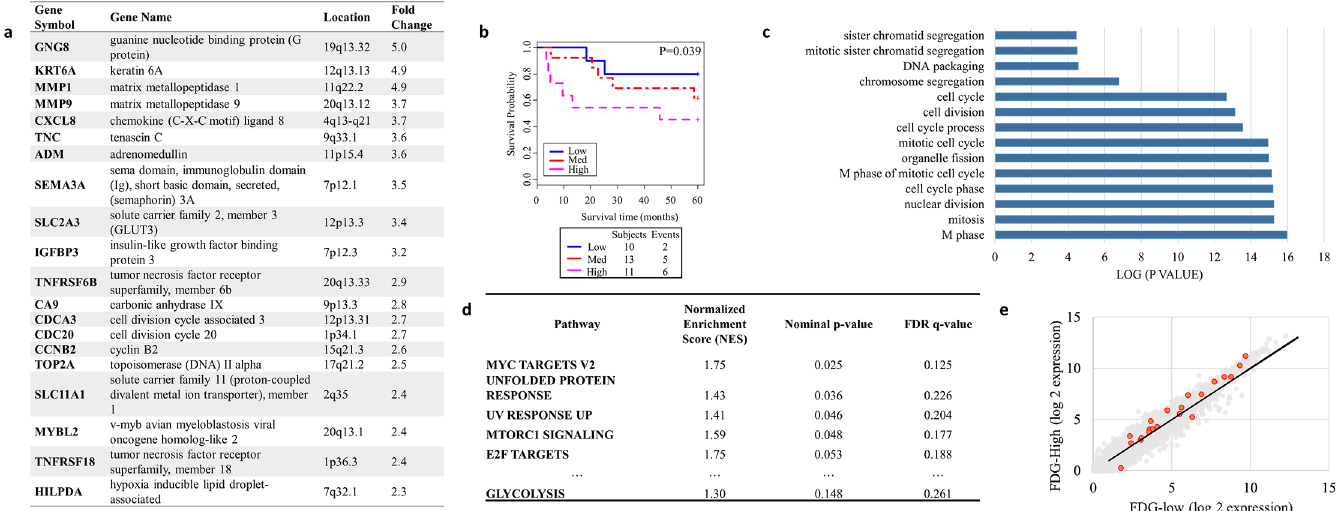
Fig 1. Genetic analysis of study group. (a) Selected genes upregulated in high PET intensity tumors (fold-change high vs. low > 2, p < 0.05). (b) Kaplan-Meier survivor curve representing overall survival (in months) for patients with high PET-intensity tumors (N = 11), medium intensity tumors (N = 13), and low intensity tumors (N = 10). (c) The most significantly enriched genes in PET-high tumors (p < 0.05, fold change > 2.0) were interrogated by DAVID gene ontology pathway analysis [24]. Significant functional groups are shown. P-values are quantified as log units. (d) Average rank-based GSEA results for MSigDB Hallmark pathways. (e) RNA levels of core glycolysis enzymes (red) versus all genes (gray) in PET high (y axis) versus low (x-axis) tumors. “Core” enzymes were labeled such according to the KEGG gene set database.